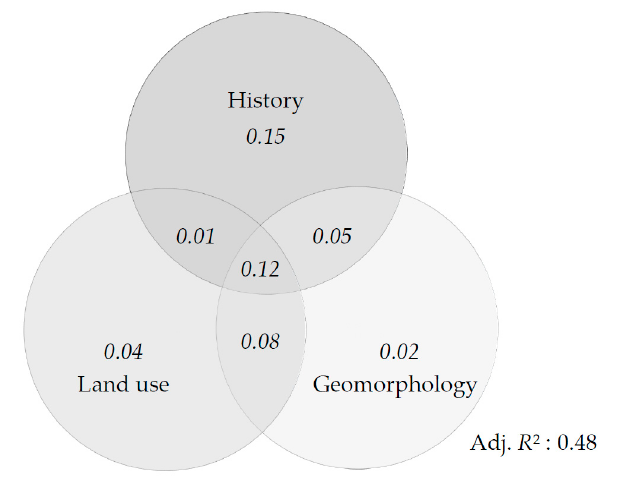
Figure 8. Venn diagram showing the contribution of each thematic group of variables to explain the distribution of biomass. The values shown correspond to the adjusted R 2 .